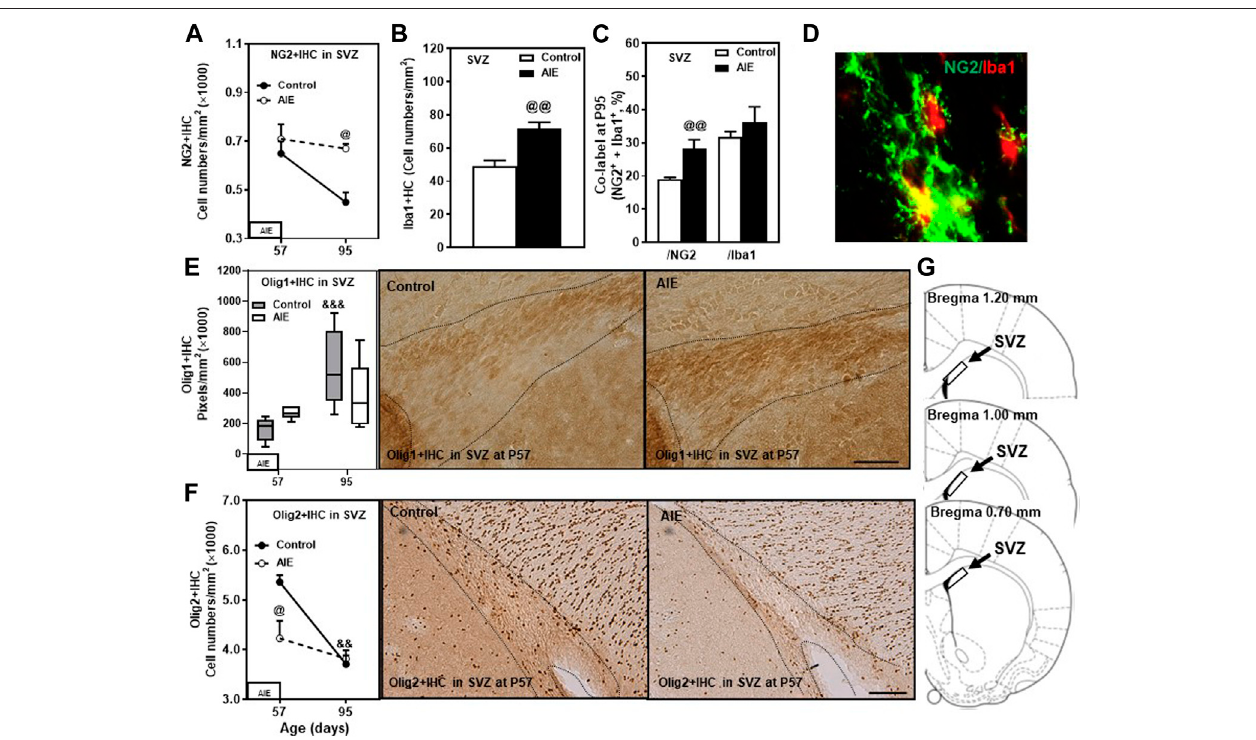
FIGURE6| EffectsofageandAIEonOPC-OLmarkersinthesubventricularzone(SVZ). (A) NG2+IHCexpressionwashigherintheAIEgroupthancontrolsatP95 (50%). NG2+IHC expression showed maturational decline in controls (32%). (B) AIE exposure resulted in an increase of Iba1+IHC expression (47%) compared with controlsatP95. (C) AIEexposureresultedinanincreaseofco-localizationofNG2+/Iba1+cellsintotalNG2+cells(28%)comparedwithcontrolsatP95.50 – 100NG2+or Iba1+ positive cells per sample were analyzed for co-localization with Iba1+ or NG2+ cells. The percentage of co-localization in NG2+ or Iba1+ positive cells was calculated . (D) Photomicrographs of co-labeled images in the SVZ, NG2+ (green) and Iba1+ (red), image 40 × . (E) Left side: Olig1+IHC expression showed maturational augmentationincontrolsfromP57toP95.Rightpanel:Olig1+IHC expression intheSVZ(Immunohistochemical staining,Barscale (cid:1) 25 µm). (F) Leftside:AIEexposure decreased Olig2+IHC expression at P57(23%) but notat P95.Olig2+IHCexpression showed maturational decline incontrolgroupfrom P57toP95(31%). Rightpanel: Olig2+IHCexpressioninSVZ(Immunohistochemicalstaining,Barscale (cid:1) 50 µm). (G) Thesubventricularzoneofmaleratbrainwasusedbythehistologicalmethod.The positive cells of oligodendrocyte progenitor markers of frame areas were counted. Rat atlas panels were reprinted from Paxinos and Watson (2014). Data were expressed as the numbers ofNG2+ (A) , Iba1+ (B) and Olig2+IHC (F) positive cells, and the pixels of Olig1+IHC (E) .Each point ismean ± SEMper mm 2 ; n (cid:1) 7 – 8/group.